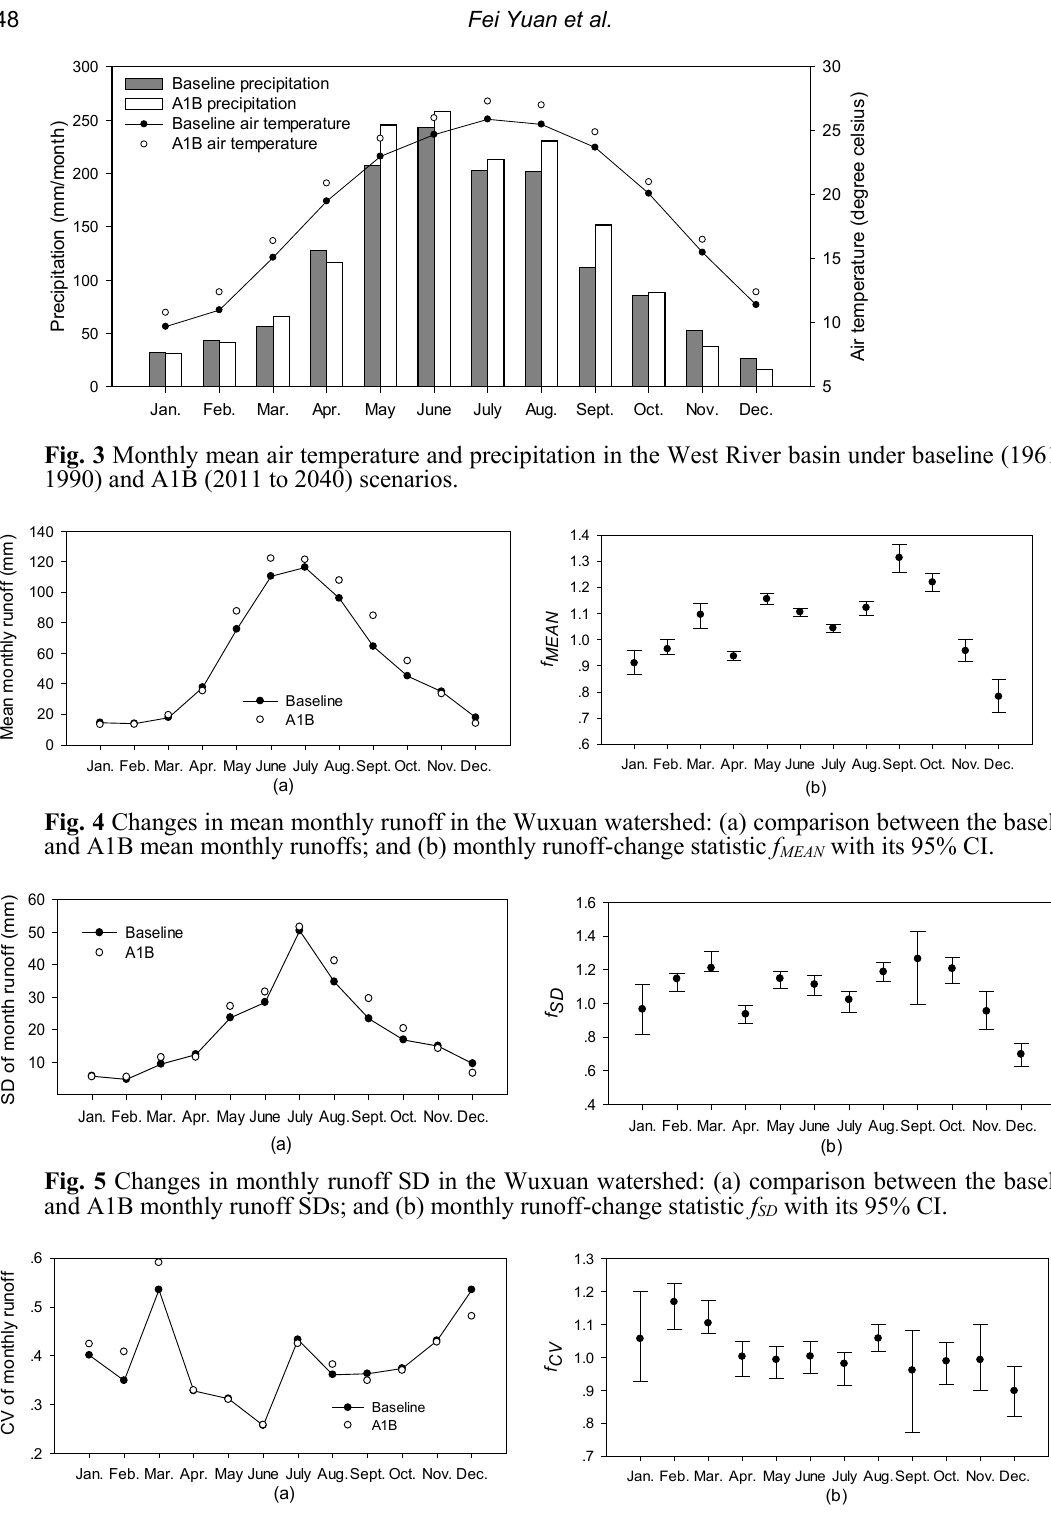
Jan. Feb. Mar. Apr. May June July Aug.Sept.Oct. Nov.Dec. (a) Fig. 6 Changes in monthly runoff CV in the Wuxuan watershed: (a) comparison between the baseline and A1B monthly runoff CVs; and (b) monthly runoff-change statistic f CV with its 95% CI. Future changes in